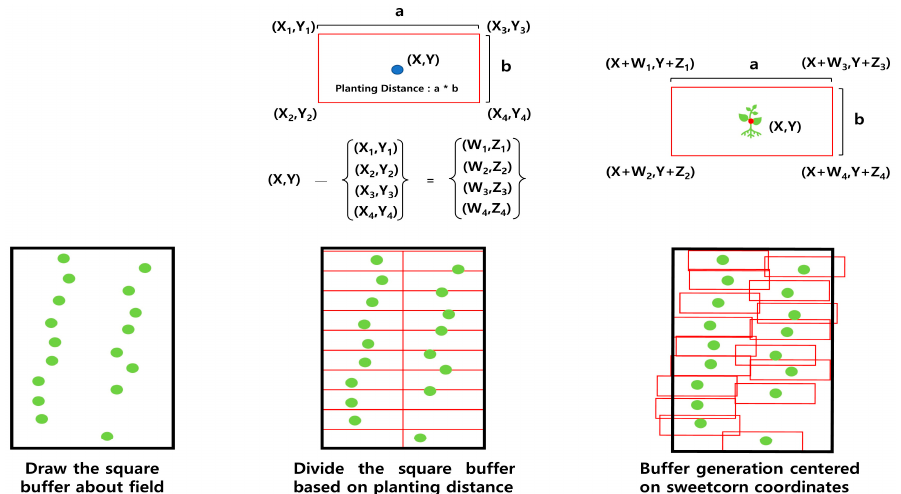
Figure 4. Simple description for making plant − based buffer data: Before making the plant − based buffer, each buffer does not contain a plant, and the plants are arranged in disorder, regardless of the buffer. All buffers have a plant in the center after calculating the coordinates of each vortex based on the planting distance and generating the plant − based buffer.